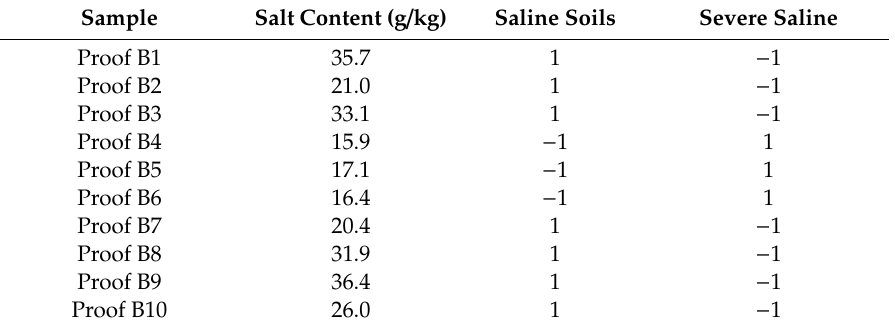
Table 6. Comparison of extension classification correlation value and salt content in Area B’s verification set.